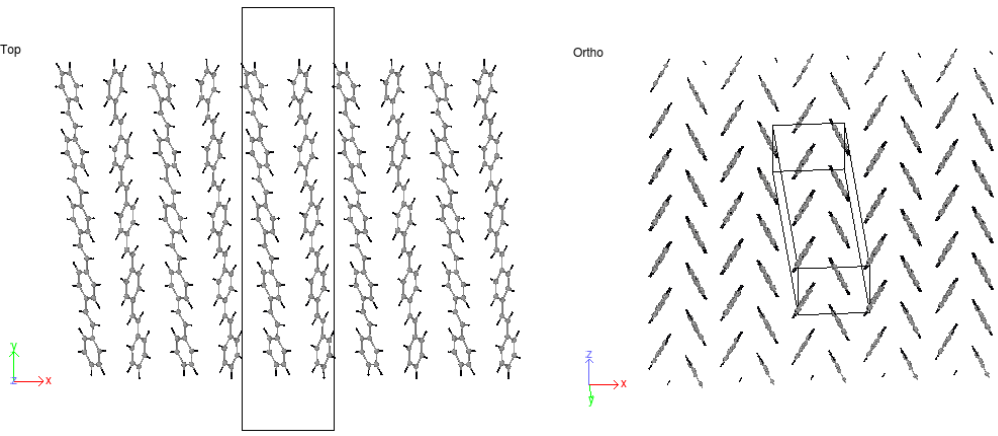
Figure 14. 5PPV HB-packing from simulation.